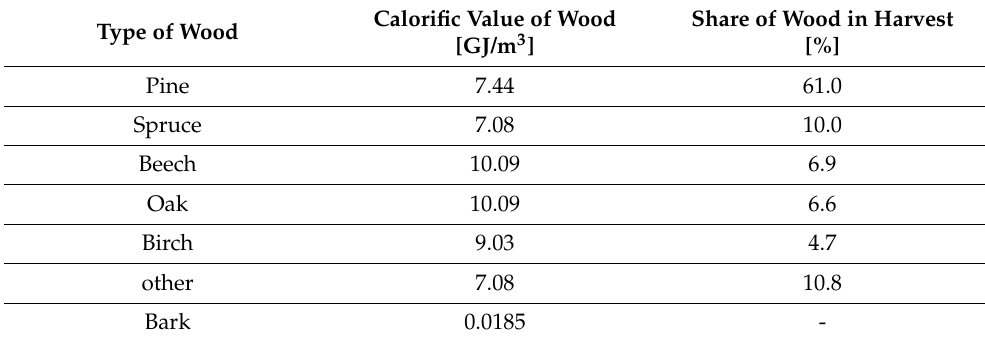
Table 1. Calorific value of selected wood materials with an average moisture content of 35%.